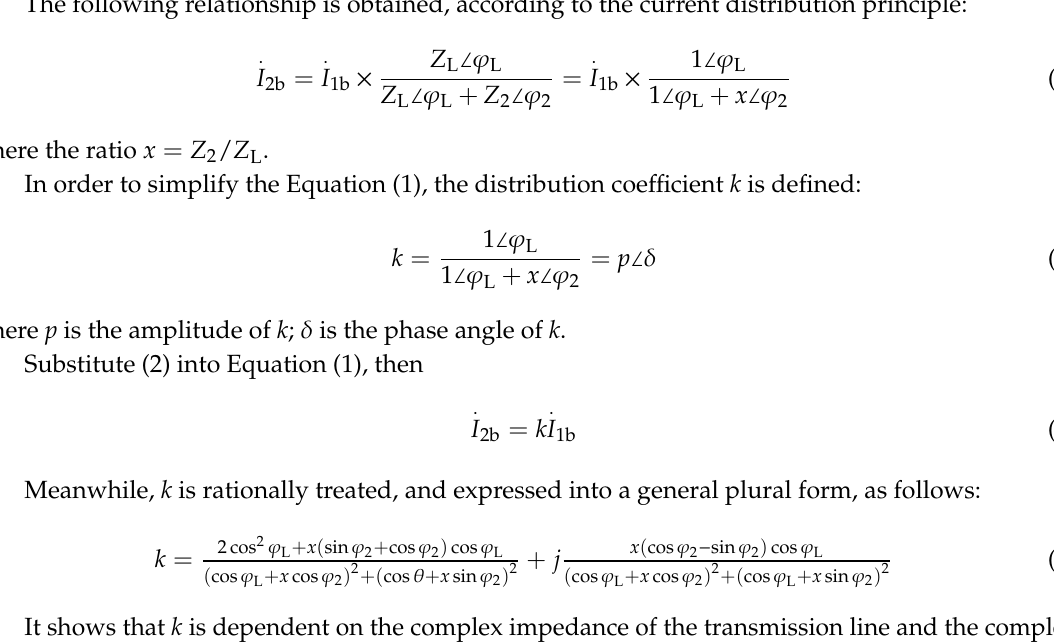
. . I 1b , I 2b are the compensation currents of the sensitive , I I are the compensation currents of the . 1b 2b I b is the compensation I is the b